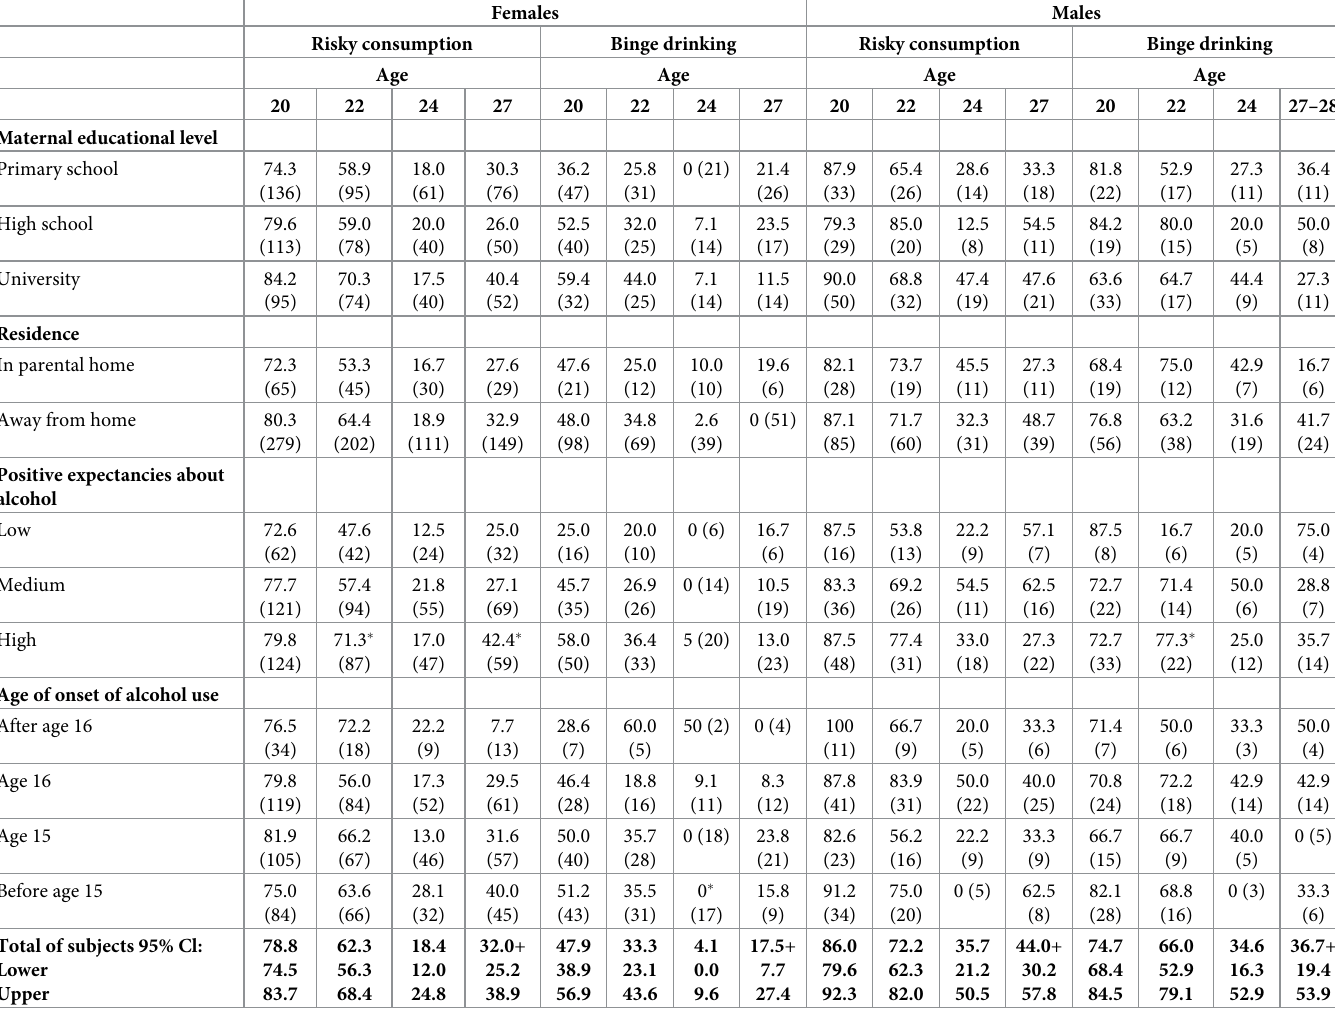
Table 3. Percentages of subjects partaking in risky consumption and binge drinking at age 20, 22, 24 and 27 years, among subjects already partaking in each of these consumption patterns at age